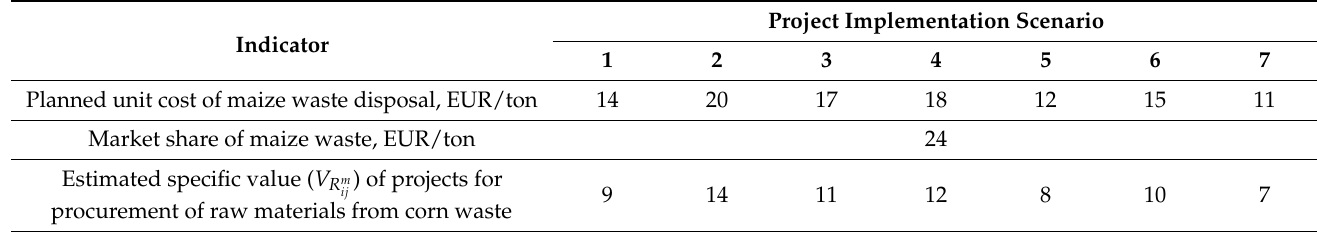
Table 1. Results of forecasting the specific values ( V R m raw materials from corn